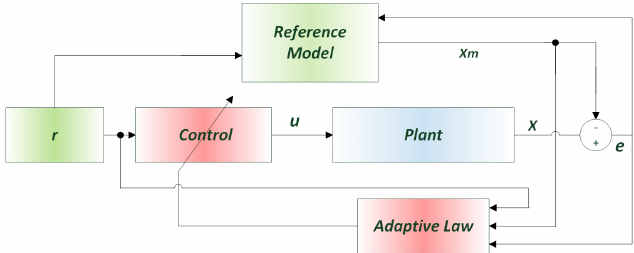
Figure 3. FOCMRAC (Fractional-Order Closed-Loop Model Reference Adaptive Control)